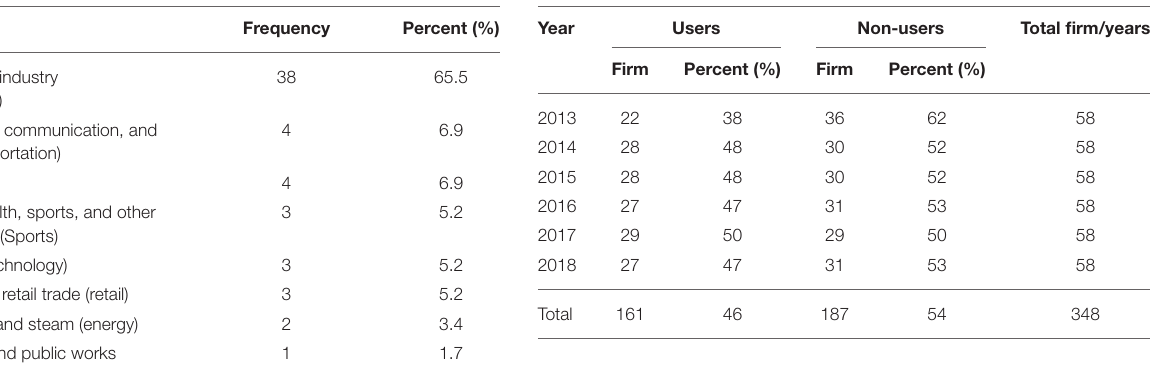
TABLE 1 | Sectoral distribution and weights of companies. TABLE 2 | Use of derivatives against financial